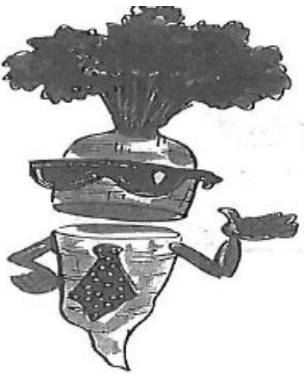
Figure 10: Uncaptioned